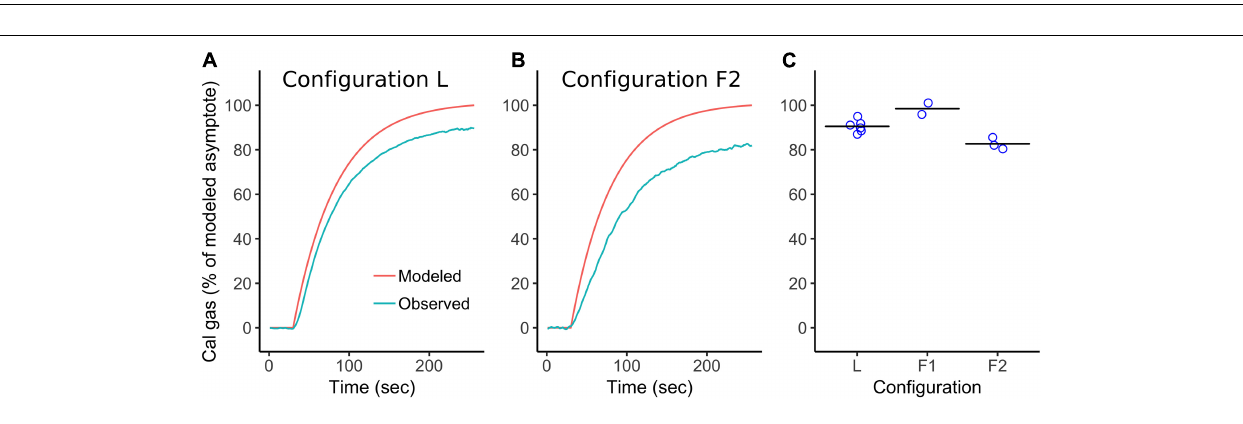
FIGURE 9 | Calibration gas is piped to leaf cuvettes to simulate leaf emissions in order to validate emission calculations from curves of concentration changes. Calibration correction factors are derived from emission simulations to correct for the effect of pressure differential between calibration and sample modes on PID sensor readings. (A) Example of a simulated emission showing expected (modeled) and observed cuvette concentrations measured by PID under a laboratory configuration. (B) Example of a simulated emission under the F2 field configuration. (C) Observed concentrations at 210 sec as a percentage of expected concentrations during simulated emissions under three different plumbing configurations, one lab, two field. Mean values [horizontal lines in (C) ] are used to correct sample readings for the effect of the pressure drop for a given sampling